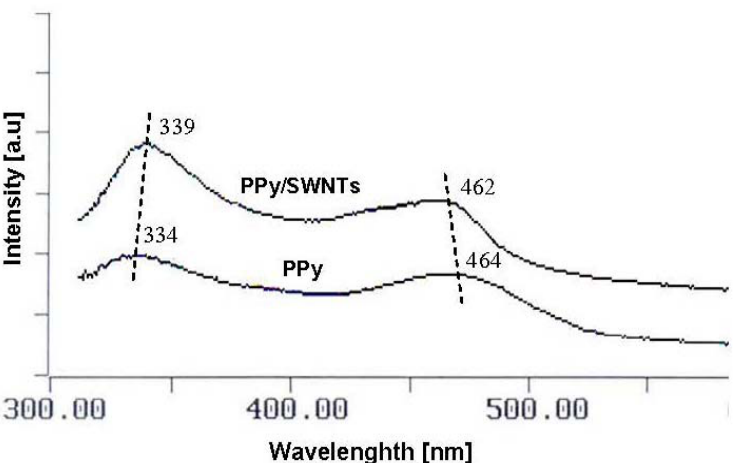
Figure 5. UV-Vis spectra of PPy and PPy/SWNTs